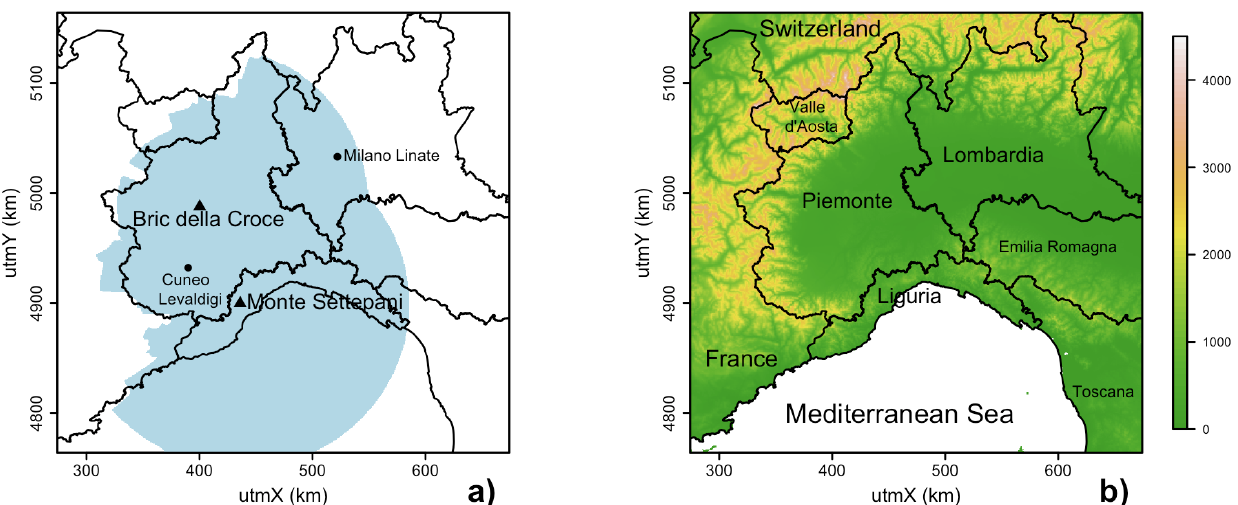
Figure 1. ( a ) The area considered during the analysis: triangles and dots show respectively the location of weather radars and of radiosounding stations; ( b ) The altimetry of the